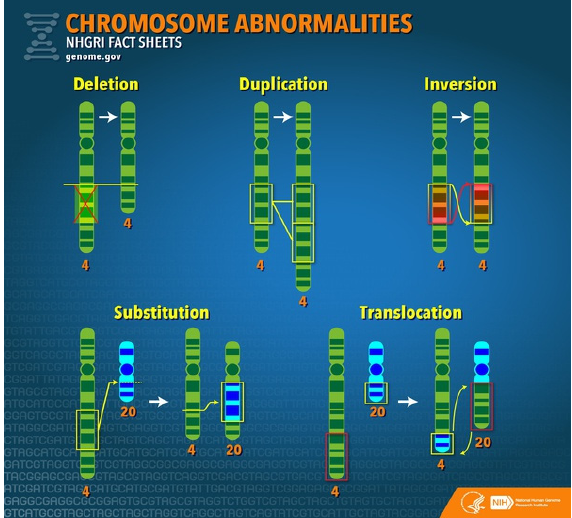
Figure 4. Common structural chromosomal anomalies resulting in abnormal genotype.